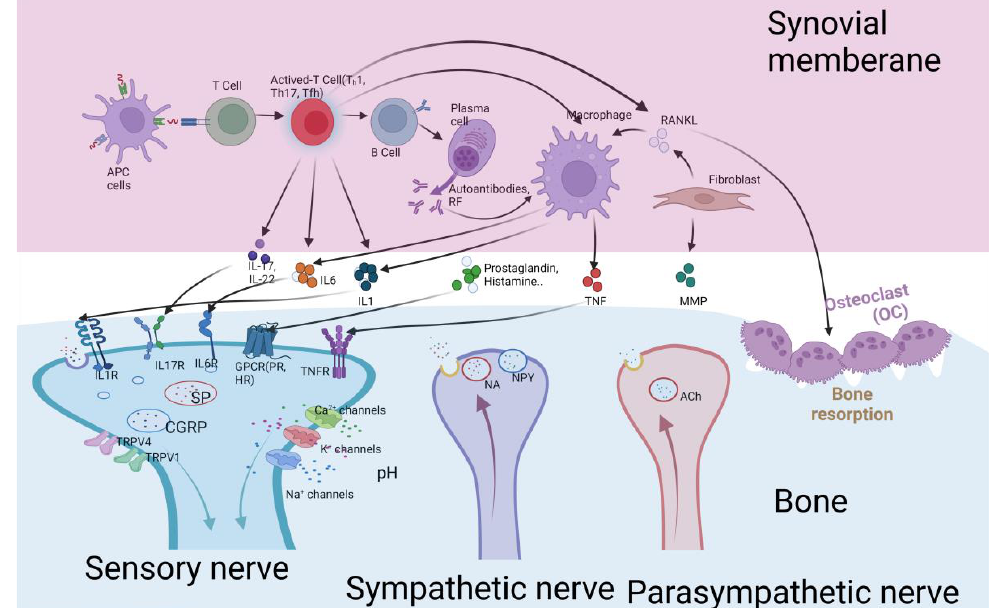
Figure 2. Molecular mechanisms underlying immune-neuron interface. Schematic: Sensory, sympa- thetic, and parasympathetic nerve fibers innervate immune cells during inflammation in RA. Rheu- matoid arthritis is characterized by synovial infiltration of multiple joints, including T cells, B cells, and monocytes. The expansion of synovial fibroblast-like cells and macrophage-like cells led to the proliferation of the synovial lining layer. This dilated synovium, invades the bony cartilage joints around the joints, causing bone erosion and cartilage degeneration. During this process, activated T cells, B cells, plasma cells, macrophages, and fibroblasts release a variety of immune factors, such as IL-1, IL-6, IL-17, IL-22, and TNF. With joint cartilage injury, sensory nerve endings infiltrate the joint. Sensory nerves express IL-1R, IL-6R, IL-17R, TNFR, and other receptors, which sense joint lesions to transmit information to the dorsal root ganglia or the CNS, resulting in the release of CGRP, SP, and other neuropeptides. Sympathetic and parasympathetic nerves are also present in the joints. The main neurotransmitters of the sympathetic nerve are NA and NPY, and the sympa- thetic nerve is a single and late inflammatory effect in the early stage of inflammation. The main transmitter of the parasympathetic nerve, acetylcholine, acts to inhibit inflammation. IL-1 (interleu- kin-1), IL-6 (interleukin-6), IL-17 (interleukin-17), NA (noradrenaline), NPY (nerve peptide Y), Ach (acetylcholine), CGRP (calcitonin gene-related peptide), SP (substance P), TRPV1 (transient receptor potential vanilloid1), and TRPV4 (transient receptor potential vanilloid 4). Figure created using Bi- oRender (https://biorender.com, accessed on 20 July 2022).